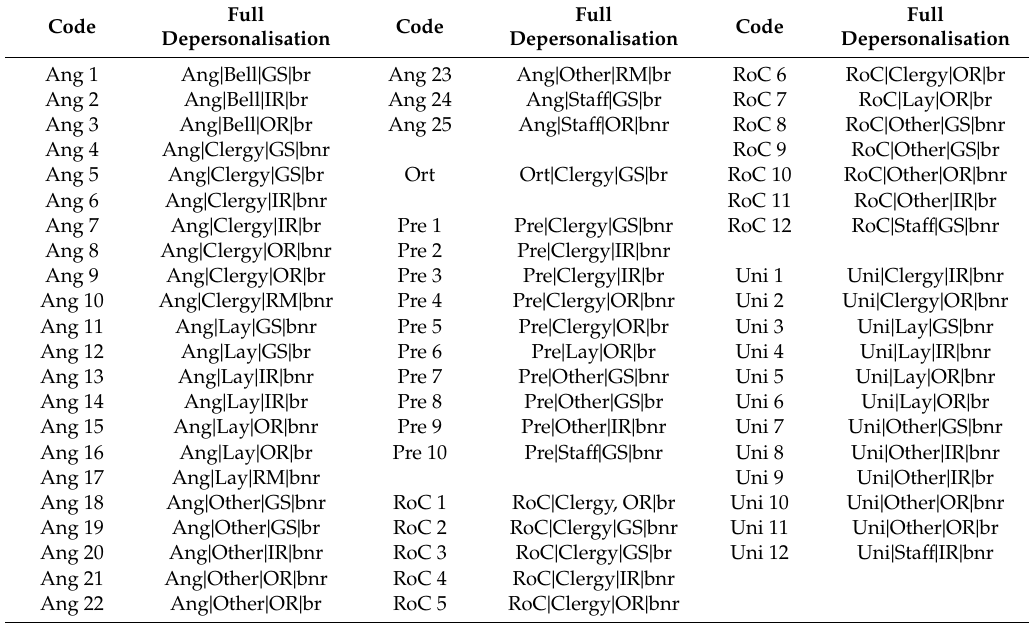
Table 3. Lookup list for depersonalisation